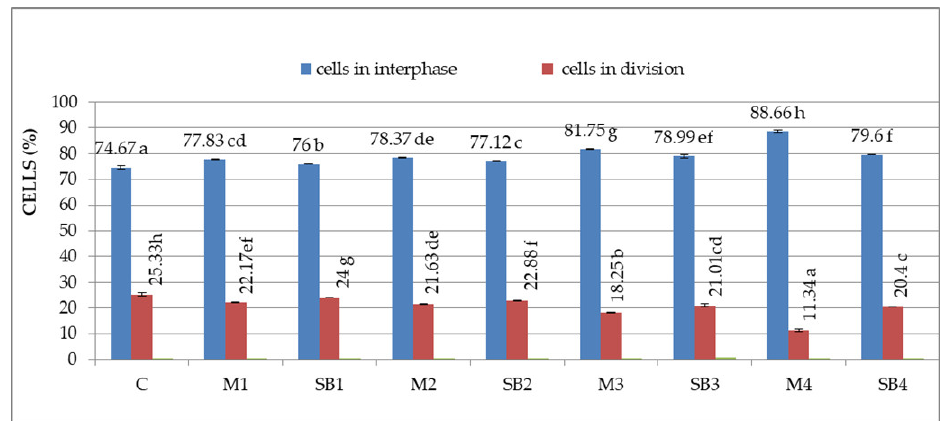
Figure 2. Cells in interphase (%) and division (%) in Triticum aestivum root meristems treated with grape marc extracts. Different letters (a–h) denote significant differences, p < 0.05.